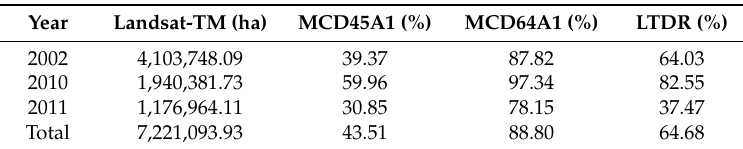
Table 4. Relative MCD45A1, MCD64A1, and LTDR BA percentages versus the reference Landsat-TM data for the Northeastern Siberian boreal region in 2002, 2010, and 2011.